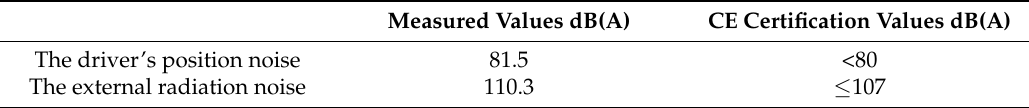
Table 1. The noise value of the wheel